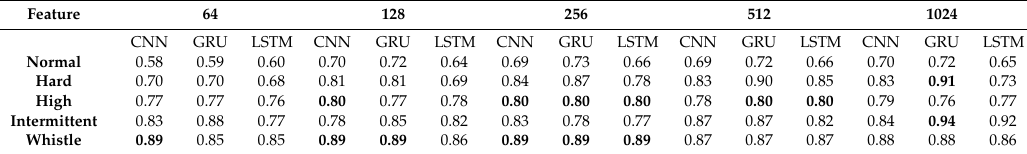
Table 4. Comparison of the areas under the receiver operating characteristic (ROC) curves (AUCs). A list of AUCs classified by each learning model, each input feature, and each sound is presented. For each sound, the item with the maximum AUC is highlighted. Hard has the best score in the GRU model using 1024 features. High is the model using 128 features, intermittent is the GRU model using 1024 features, and whistle is the CNN and GRU model using 64–256 features.